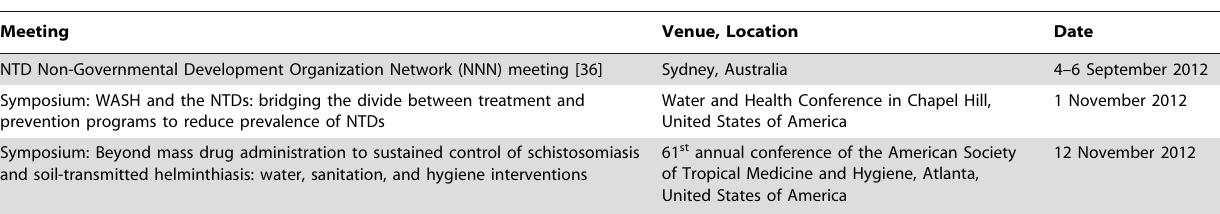
Table 3. Recent meetings to discuss NTD-WASH sector collaboration.